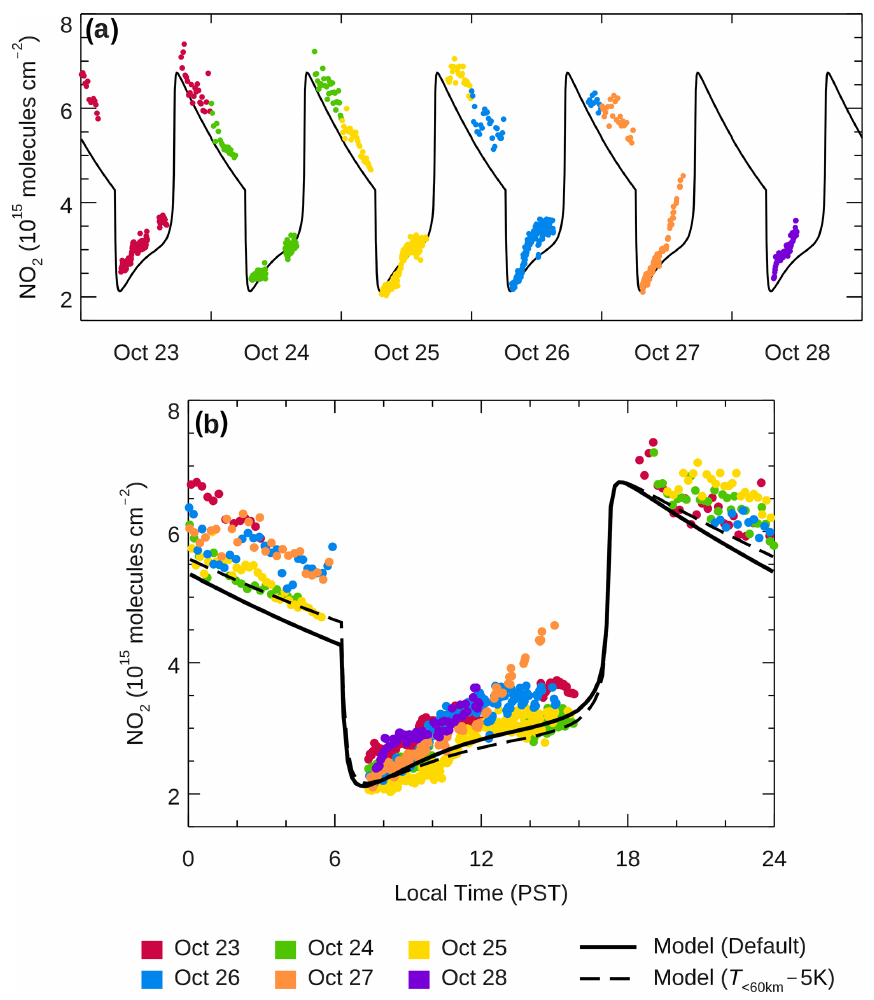
Figure 4. The column NO 2 abundance measured over TMF on 23–28 October 2018, represented by the color dots. The 1-D model simulation, with default input temperature and surface N 2 O being 330ppb, representing 26 October is shown as the solid black line. (a) The column NO 2 measurements on individual dates. (b) The aggregated column NO 2 measurements as a function of local time. An additional 1-D model simulation with temperature below 60km reduced by 5K, is shown as the dashed